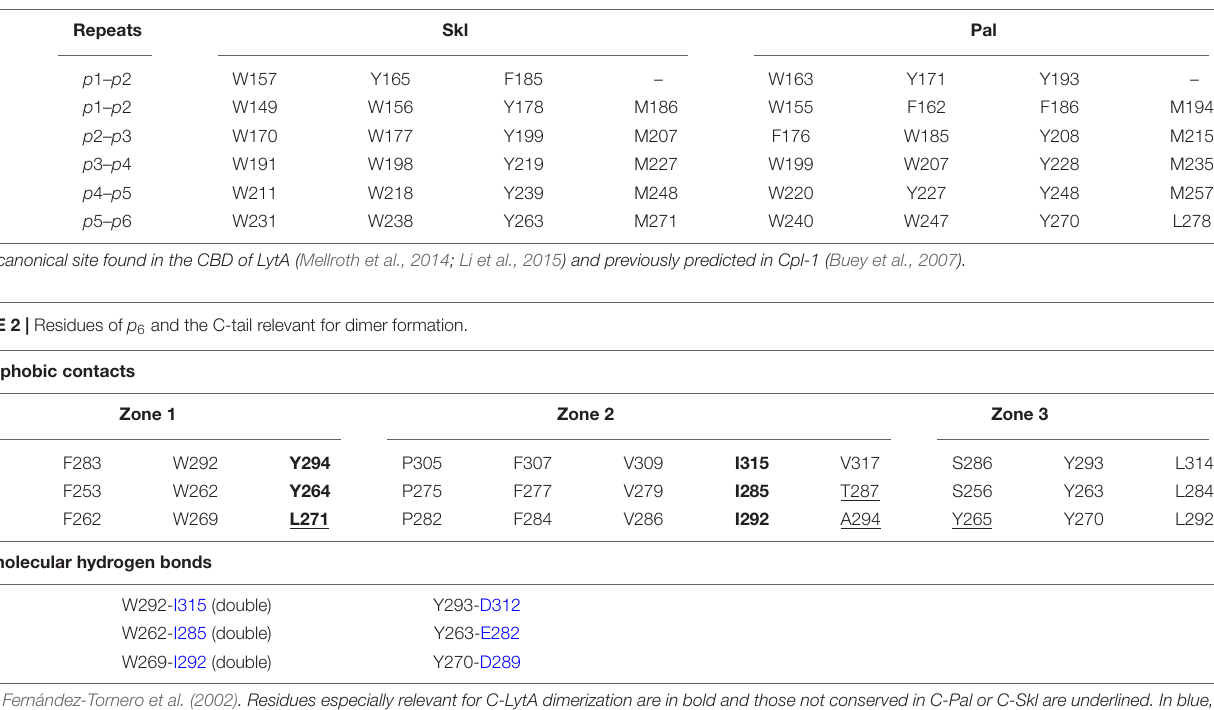
TABLE 1 | Residues conforming choline-binding sites of Skl and Pal.